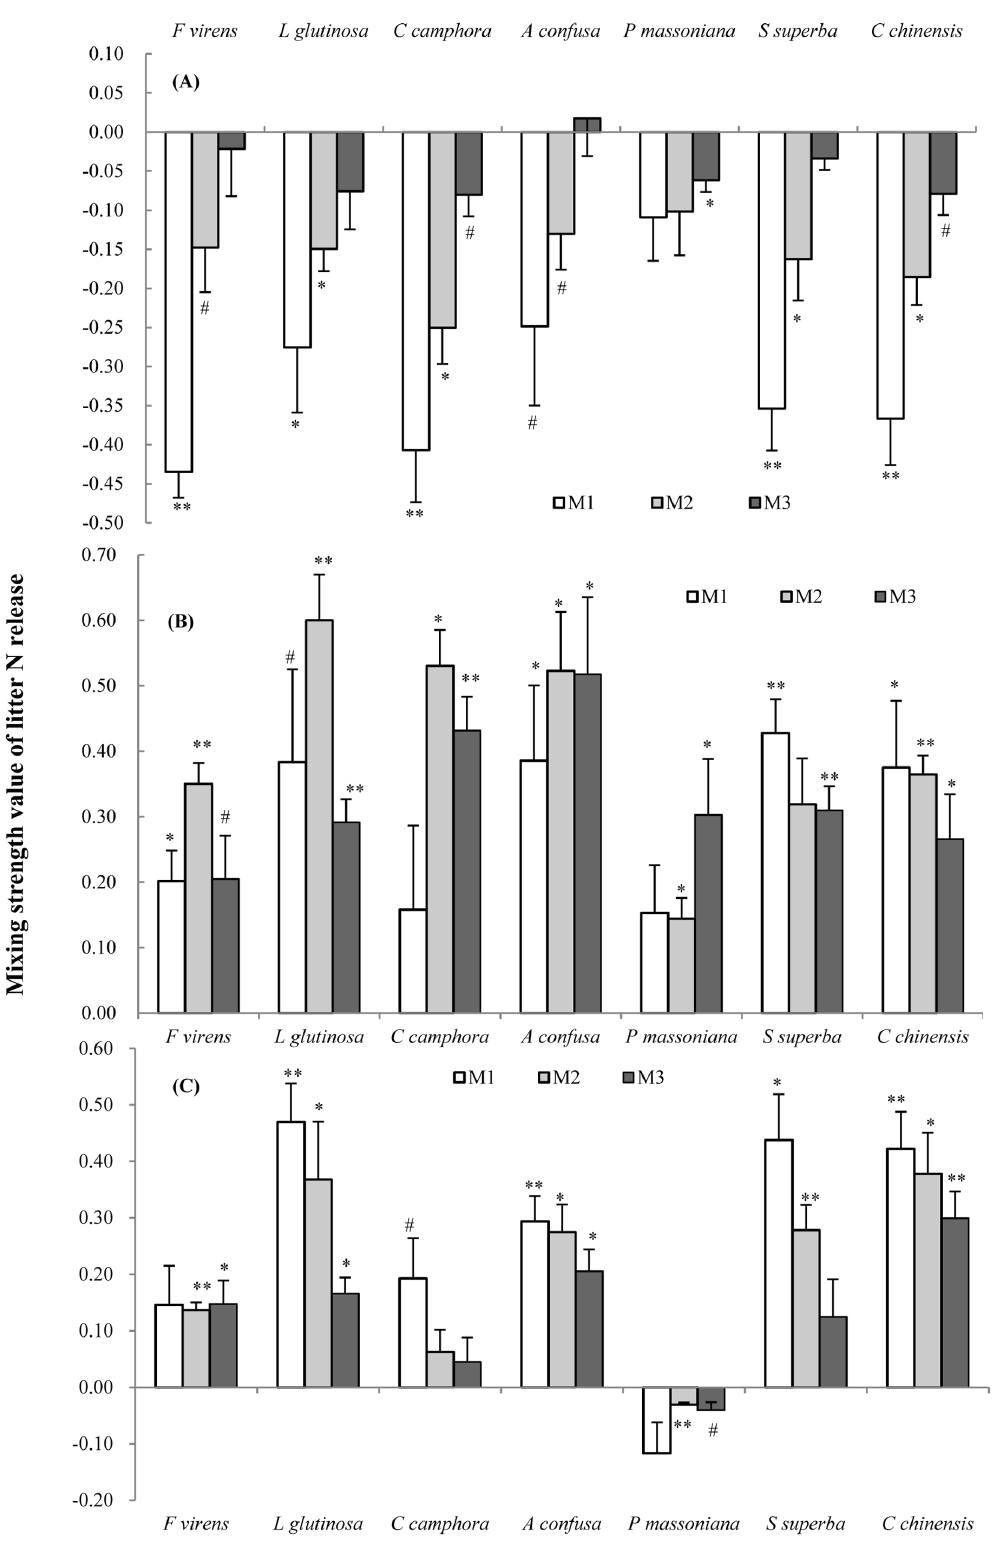
Figure 3. Mean mixing interaction strength values ( + SE, n=4) of litter N releases after 60 (A), 128 (B) and 180 (C) days decay. M 1 (1:4, mixture with 20% exotic litter), M 2 (1:1) and M 3 (4:1, mixture with 80% exotic litter) represent 3 different litter mixing ratio of M. micrantha to native species. Non-additive interactions are significantly different from zero with (**) at P , 0.01, (*) at P , 0.05, and with ( # ) at P , 0.10 tested separately with one sample t test. See Table S5 for observed N release.